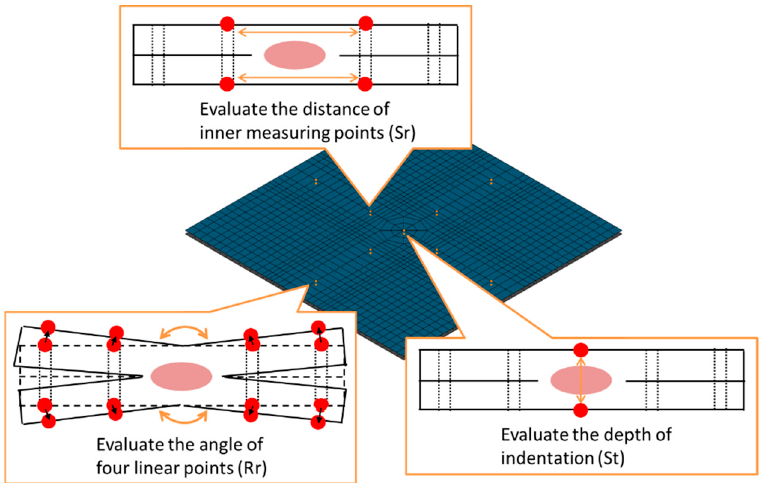
Figure 9. FE Model for identification of inherent deformation. The distance and angle for evaluating Sr, St, and Rr are computed at the measuring points highlighted in orange.